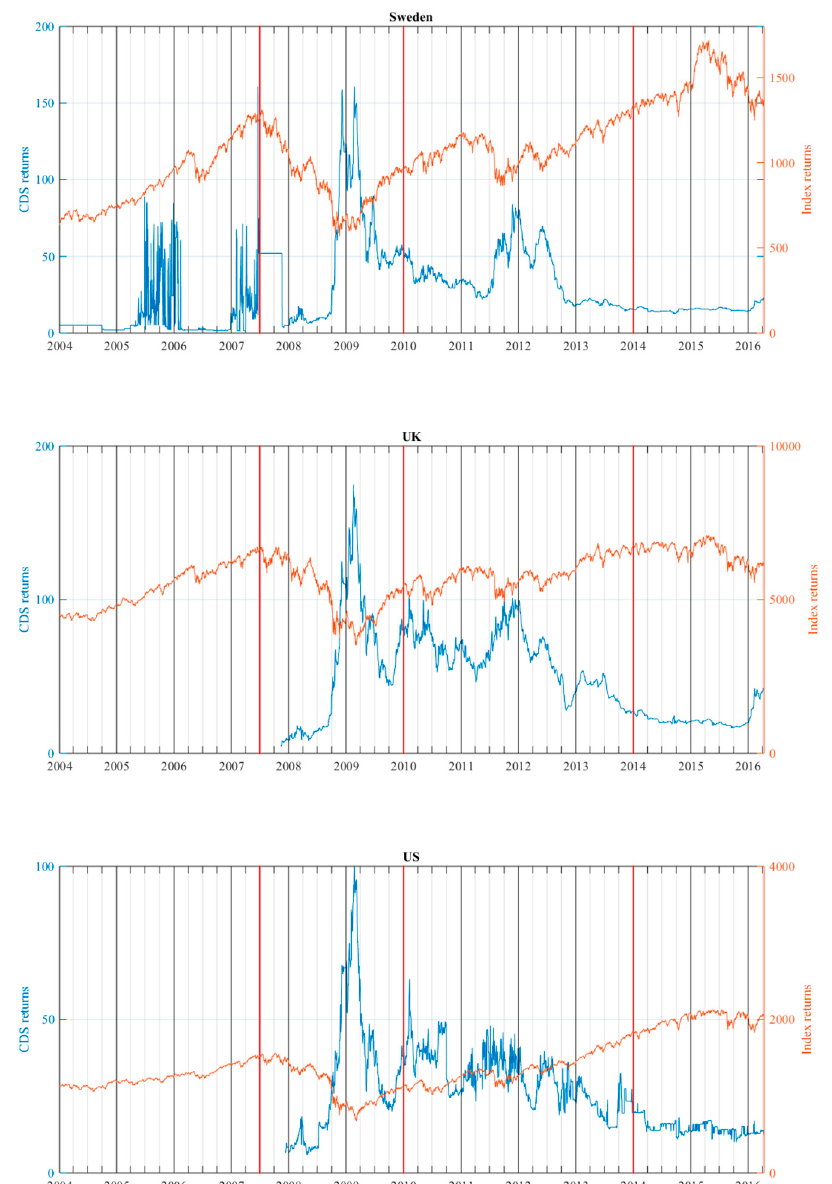
Figure 1. Daily time evolution of the European and US stock indices (in blue) and sovereign CDS spreads expressed in basis points (in orange) in the period 2004–2016. Note that from 8 March 2012 to 24 October 2014, sovereign Greek CDS ceased to be negotiated. The vertical red lines mark the beginning of the different sub-periods: global financial crisis, Eurozone sovereign debt crisis and post-crisis period.